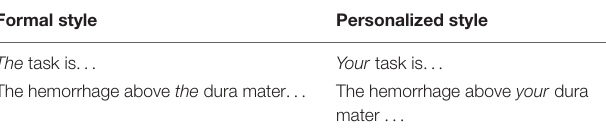
TABLE 1 | Examples of personalized and formal text